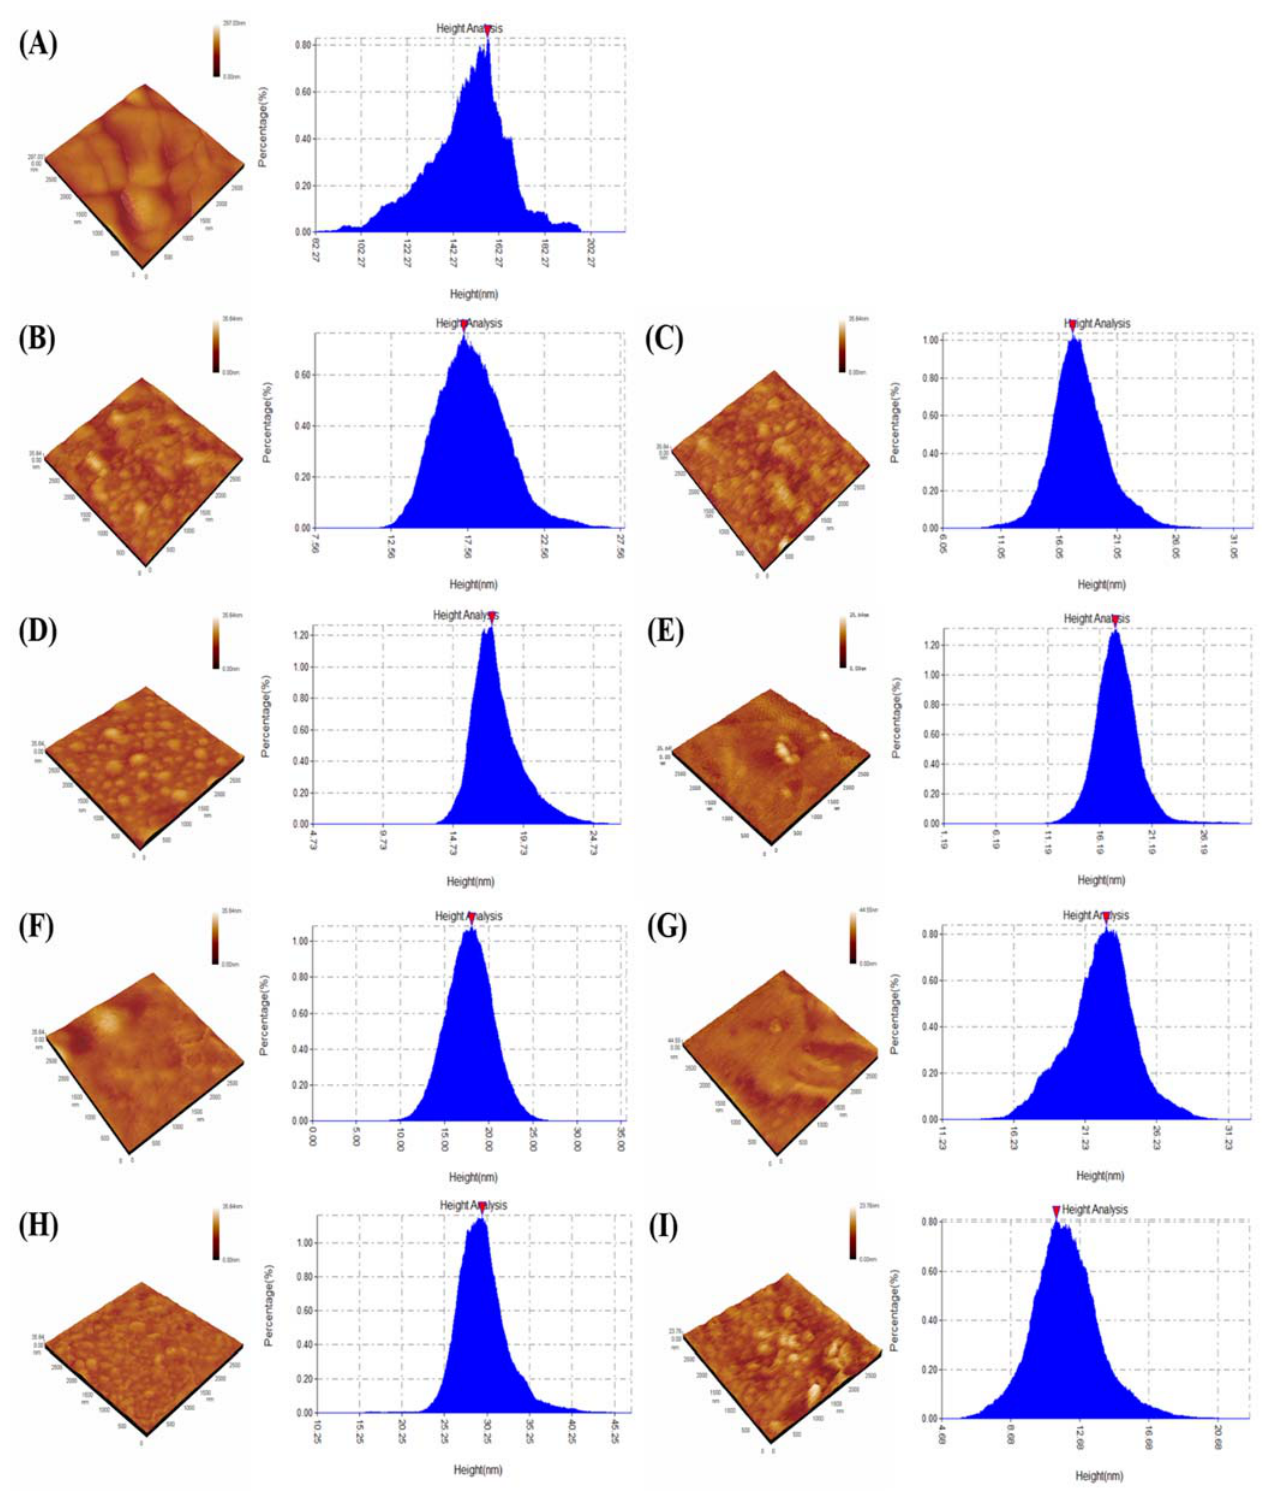
Figure 8. Surface roughness images (AFM) of the zirconia samples after dyeing. ( A ) Original, ( B ) AKZENT Plus A1, ( C ) AKZENT Plus A3, ( D ) Biomic A1, ( E ) Biomic A3, ( F ) Miyo A1, ( G ) Miyo A3, ( H ) Crystall A1 and ( I ) Crystall A3.